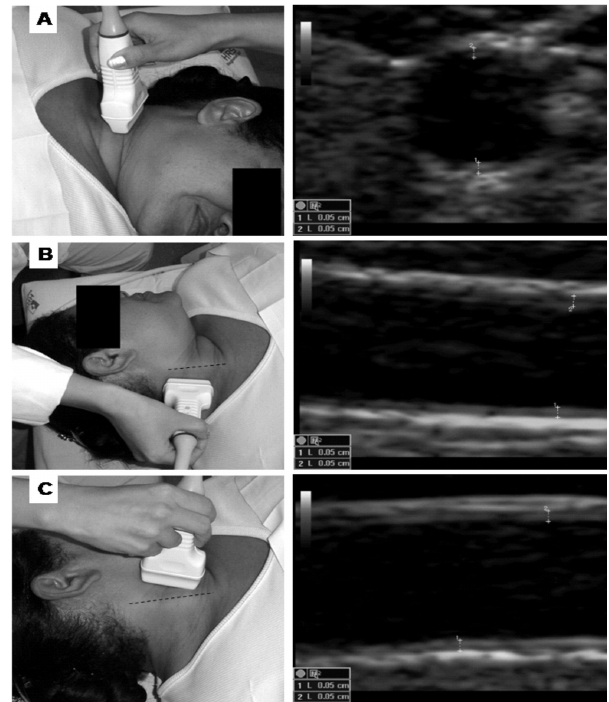
Figure 1 - Observation angles for intima-media thickness measurement: A, transversal; B, posterolateral; C, anterolateral. The dashed lines represent the sternocleidomastoid